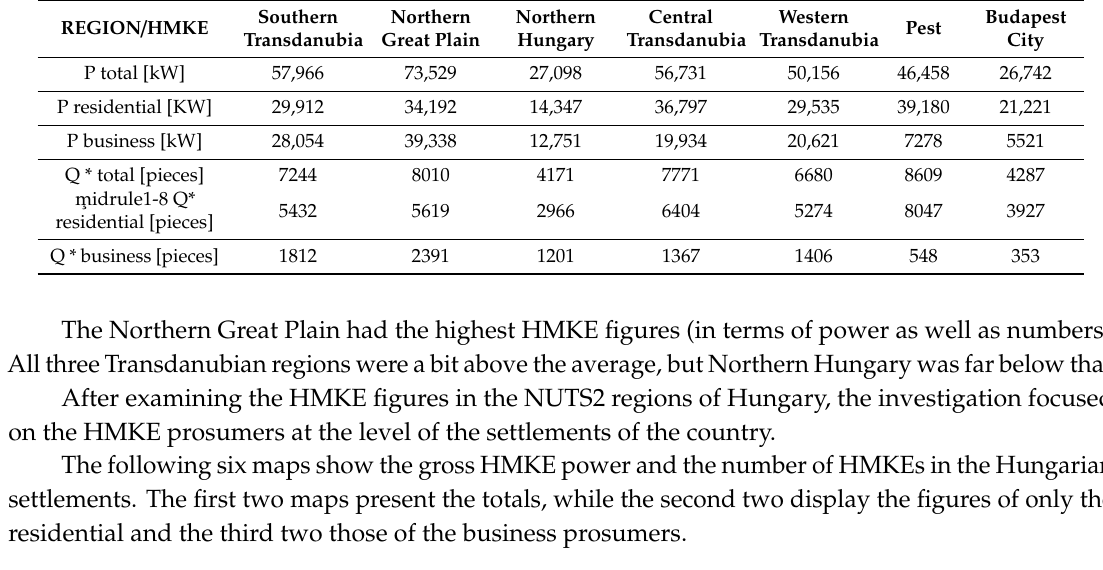
Table 4. HMKEs in the seven examined regions of Hungary. (* Quantity,